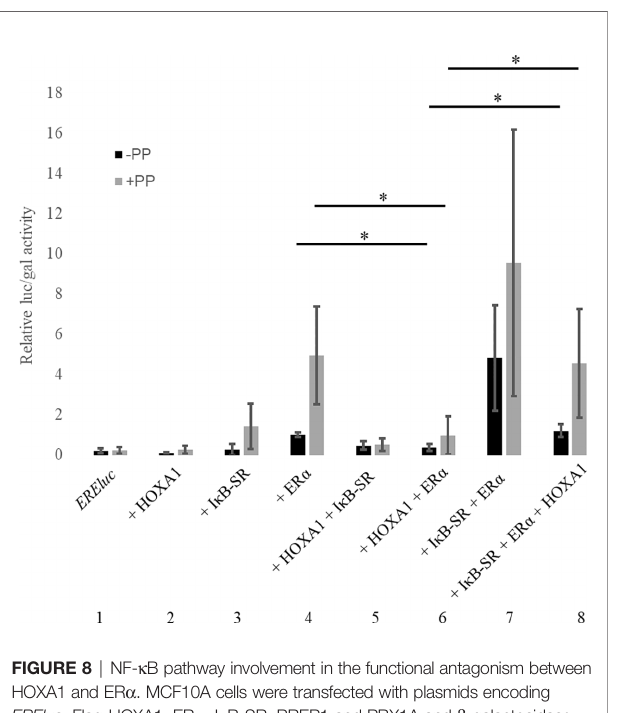
FIGURE 8 | NF- k B pathway involvement in the functional antagonism between HOXA1 and ER a . MCF10A cells were transfected with plasmids encoding EREluc , Flag-HOXA1, ER a , I k B-SR, PREP1 and PBX1A and b -galactosidase under the control of a CMV promoter. ER-mediated luciferase activity (luc) was reported to the b -galactosidase activity (gal). See text for details. PP stands for PREP1 and PBX1A. The activation of EREluc in presence of ER a was set to 1. * means p < 0,05 (N ≥ 3, n=2). Error bars represent standard deviation for N experiments and n replicates per